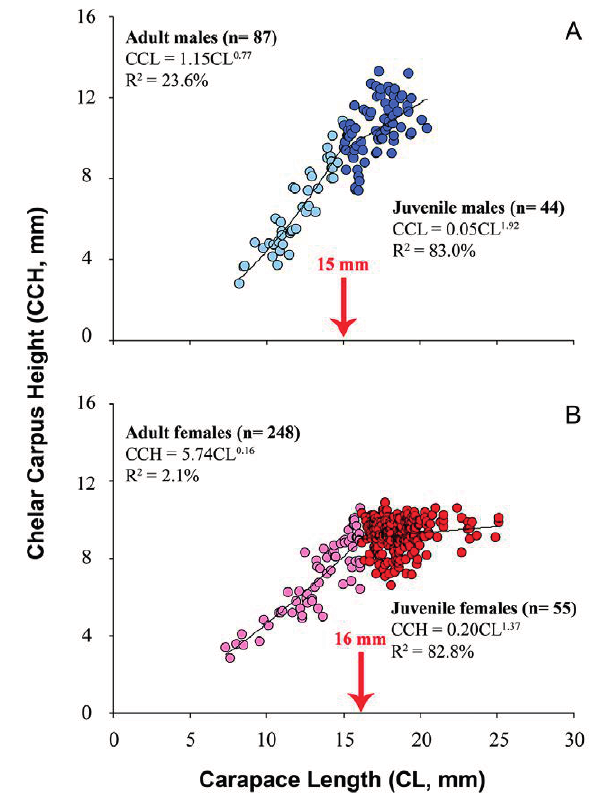
Fig. 4. – Biometric relationship CCH vs. CL, regression analyses of both development phases in males (A) and females (B), and size of morphological maturity. CCL, carpus length of the major cheliped; CL, carapace length; light points, juveniles; dark points, adults. Table 2. – Callichirus major (Say, 1818). Handedness ratio (HR) in each sex expressed by division of the carpus length from the right by left chelipeds (HR = CPLR / CPLL). N, number of individuals; %, relative frequency; HO, homochely; LHE, left heterochely; RHE, right heterochely; Min., minimum value; Max., maximum value; x, mean; sd, standard deviation; CV (%), percentual coefficient of variation. Handedness Ratio Chelar Min. Morphotypes